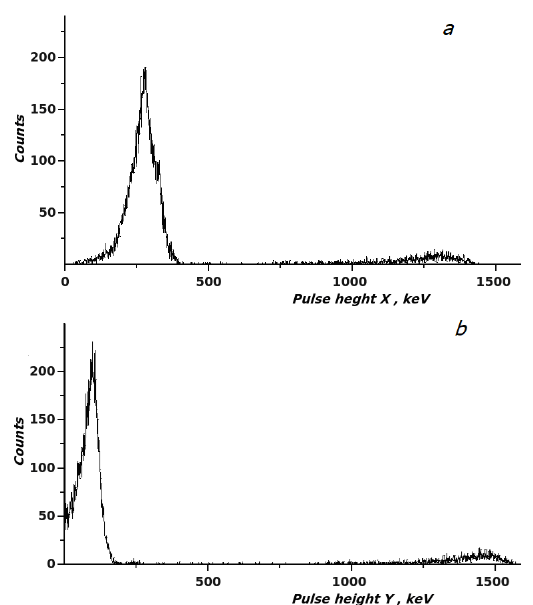
Fig. 6. The experimental ionisation loss spectra for the fast neutrons of several MeV with 10 B detector for: (a) the 1-st gap; (b) the 2-nd gap .